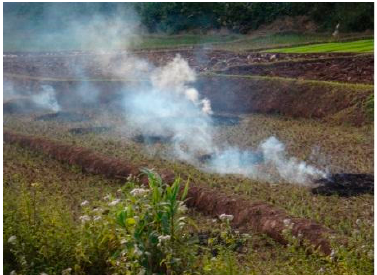
Figure 1. Outdoor Crop Burning: Example of the survey pictogram of rural life used to measure one source of air pollution.